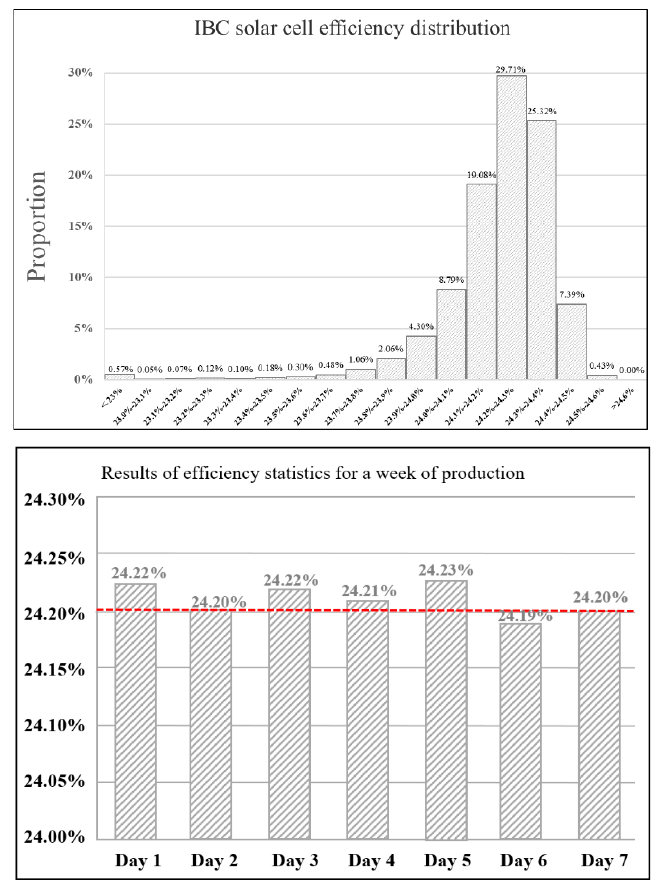
Figure 6. Distribution of IV data for all solar cells ( top ) and average on daily basis ( bottom ) for a week of production in April 2022.